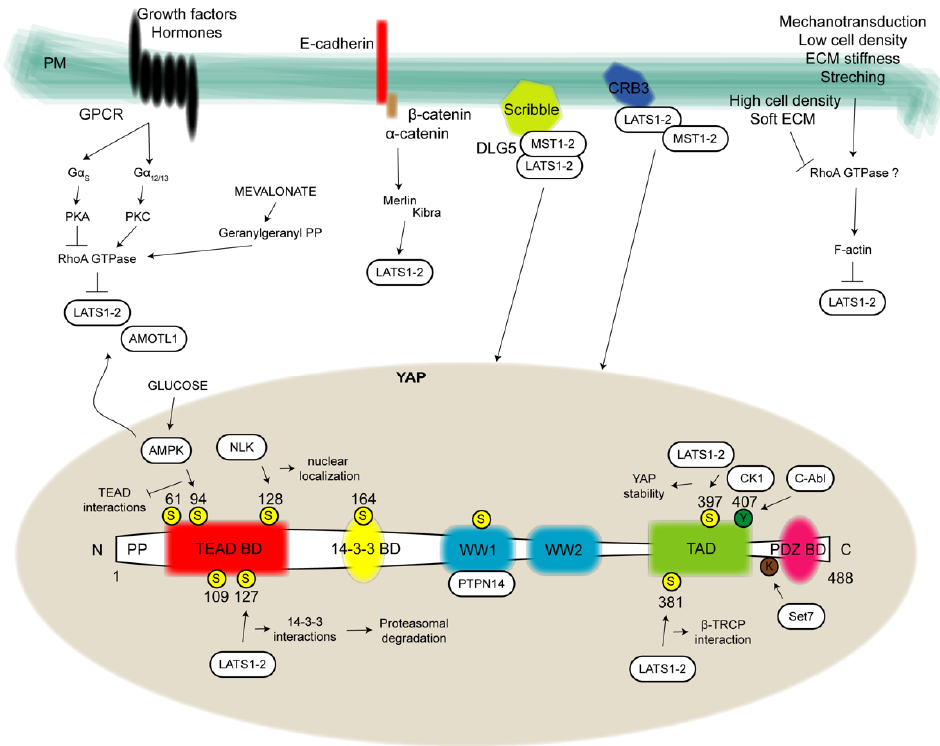
Figure 2. YAP structure and regulation. In the present figure, YAP structure (bottom) is depicted by showing all binding domains allowing protein-protein interactions to exert YAP pro-tumorigenic functions. From the N-terminus to C-terminus of the 488 aa protein it can be distinguished a proline-rich domain (PP), one TEAD binding domain (BD), one 14-3-3 BD, two WW domains, one transcriptional activation domain (TAD) and one PDZ BD. Yellow circles highlight phosphorylation sites at serine (S). Green circles evidence phosphorylation sites at tyrosine (Y) and one additional site for lysine (K) methylation is reported. Close to these regulatory sites, kinases or methyltransferase are represented in white boxes and the pathway that in turn they regulate. Upstream modulators (top) are depicted in correspondence of the plasma membrane (PM). In detail, on the left G-protein-coupled receptors (GPCRs)-mediated signal transduction by which several growth factors and hormones regulate the kinase module of the Hippo pathway via RhoA-GTPases. Going forward, the cadherin-catenin complex involved in both structural roles and in the cytoplasmic restrain of YAP. YAP cytosol-nucleus shuttling is also modulated by proteins involved in cell polarity and tight junctions, such as the Scribble complex, Crumbs (CRB) family members and Merlin which mainly operate for the recruitment, stabilization and function of the kinase module. On the right, signals of mechanotransduction such as cell density, extracellular matrix (ECM) stiffness and stretching are reported. AMOTL1: angiomotin-like 1; AMPK: AMP-activated protein kinase; C-Abl: Abl proto-oncogene; CK1: casein kinase 1; DLG5: disc large 5; NLK: nemo-like kinase; PKA: cAMP- dependent protein kinase; PKC: protein kinase C; PTPN14: nonreceptor tyrosine phosphatase 14; Set7: SET-domain containing 7, histone lysine